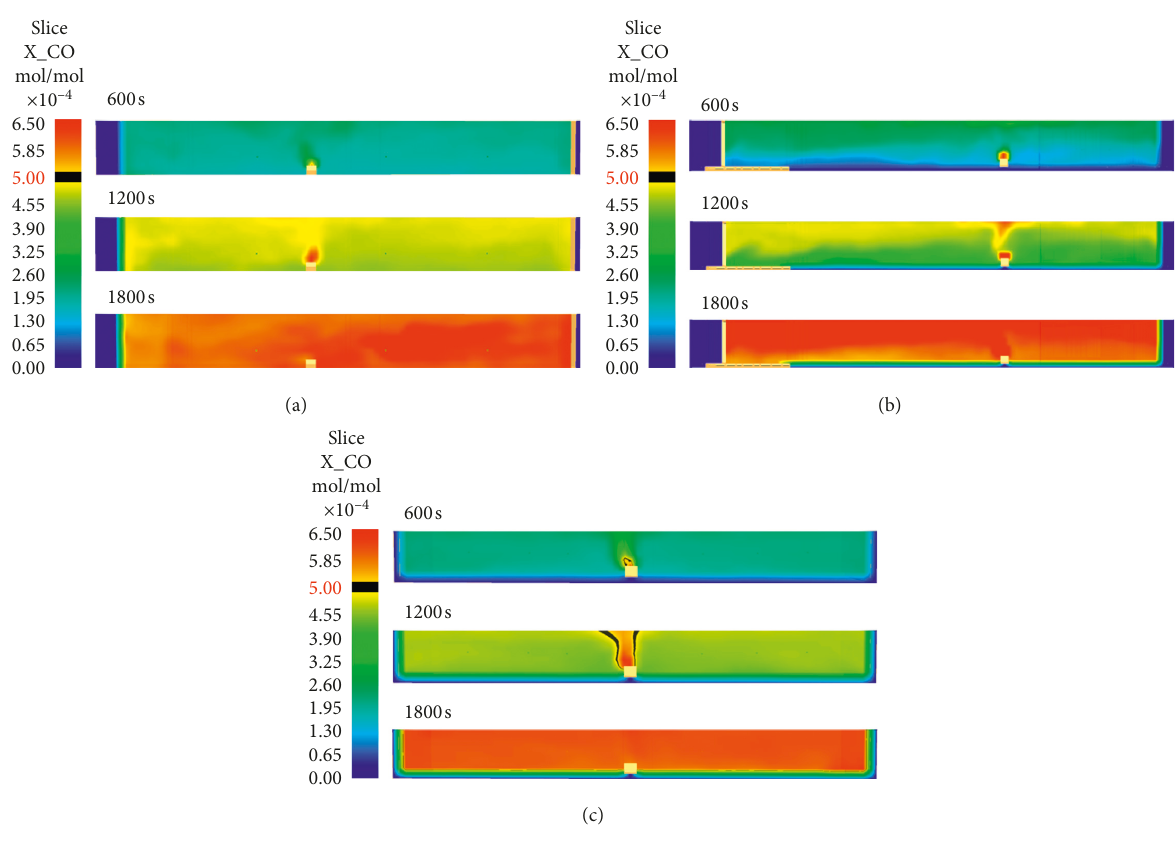
Figure 5: Slices of the CO mass fraction in different scenarios. (a) A10, (b) B10, and (c) C10.